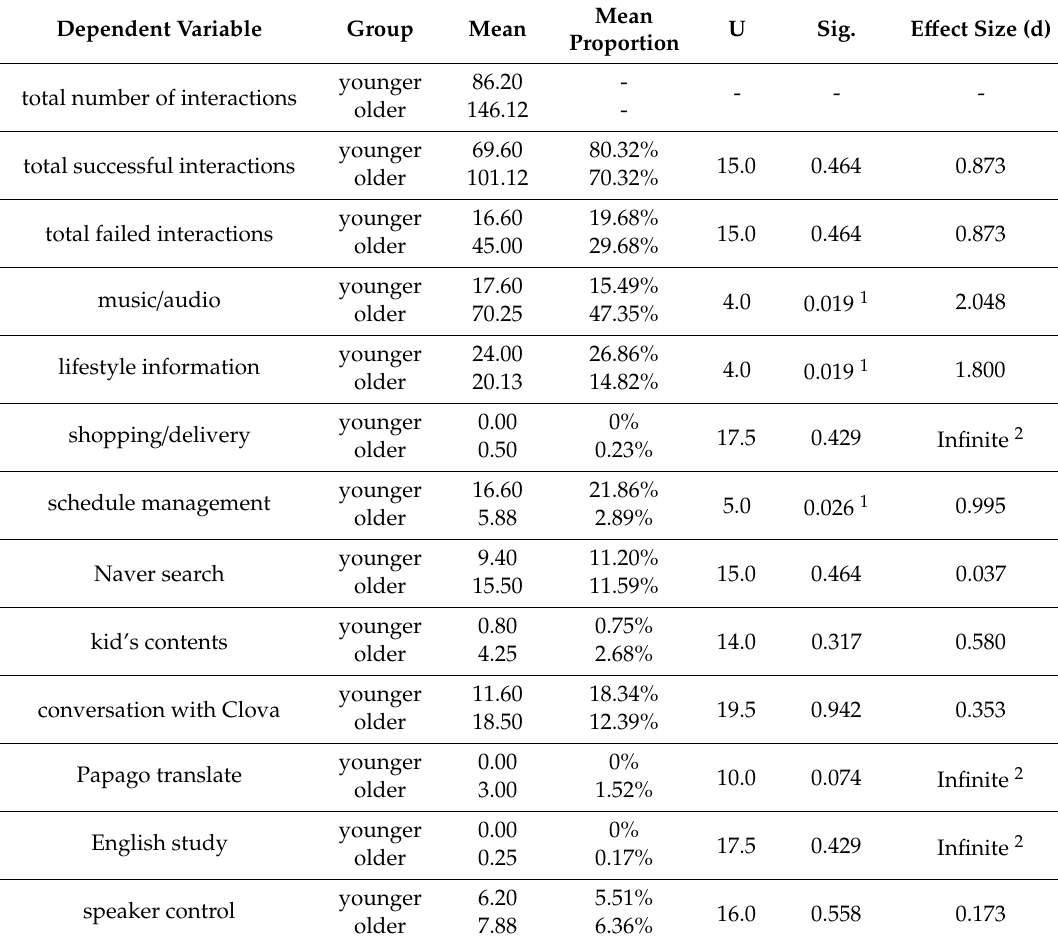
Table 3. Usage of Clova by age group: Mann–Whitney U